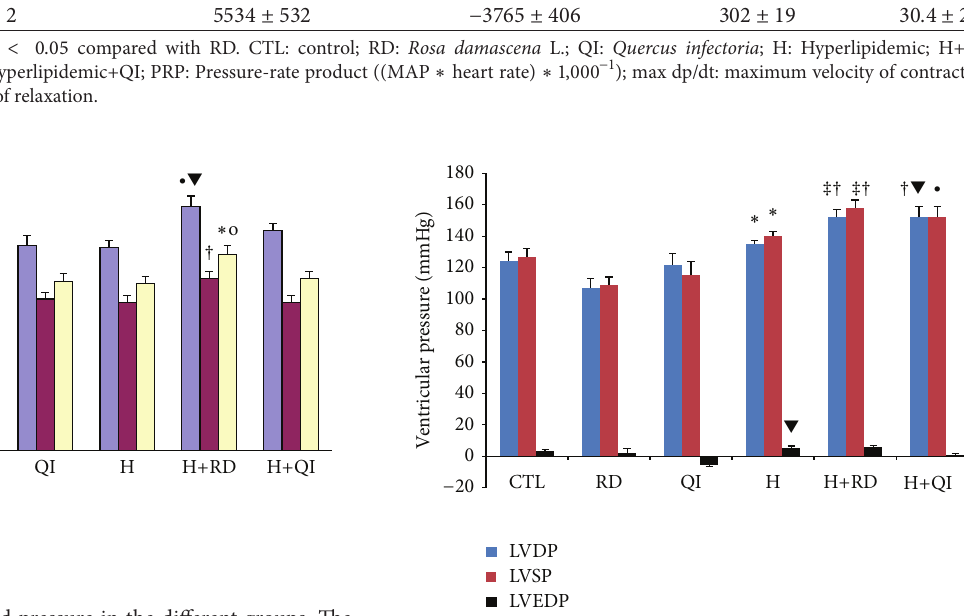
Figure 4: The left ventricular pressure in different groups. The values are Mean ± SEM. 𝑛 = 6 ; LVDP: left ventricular developed pressure; LVSP: the left ventricular systolic pressure; LVEDP: left ventricular end diastolic pressure; CTL: control; RD: Rosa damas- cena L.; QI: Quercus infectoria ; H: Hyperlipidemic; H+RD: Hyper- lipidemic+RD; H+QI: Hyperlipidemic+QI. ∗ 𝑃 < 0.05 compared to CTL; ‡ 𝑃 < 0.0001 compared with RD; † 𝑃 < 0.05 compared with RD; 󳶃 𝑃 < 0.05 compared with QI; ∙ 𝑃 < 0.01 compared with